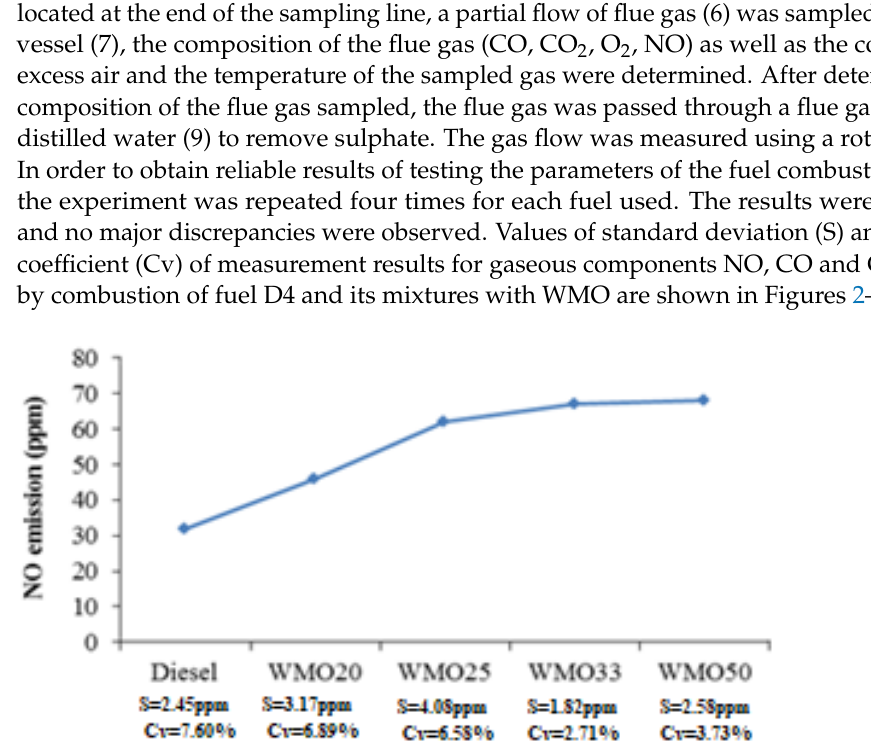
combustion, samples of various fuel mixtures were held in an open-air atmosphere (2). diesel fuel mixtures were well mixed to give a homogeneous stable mixture. Prior to com-